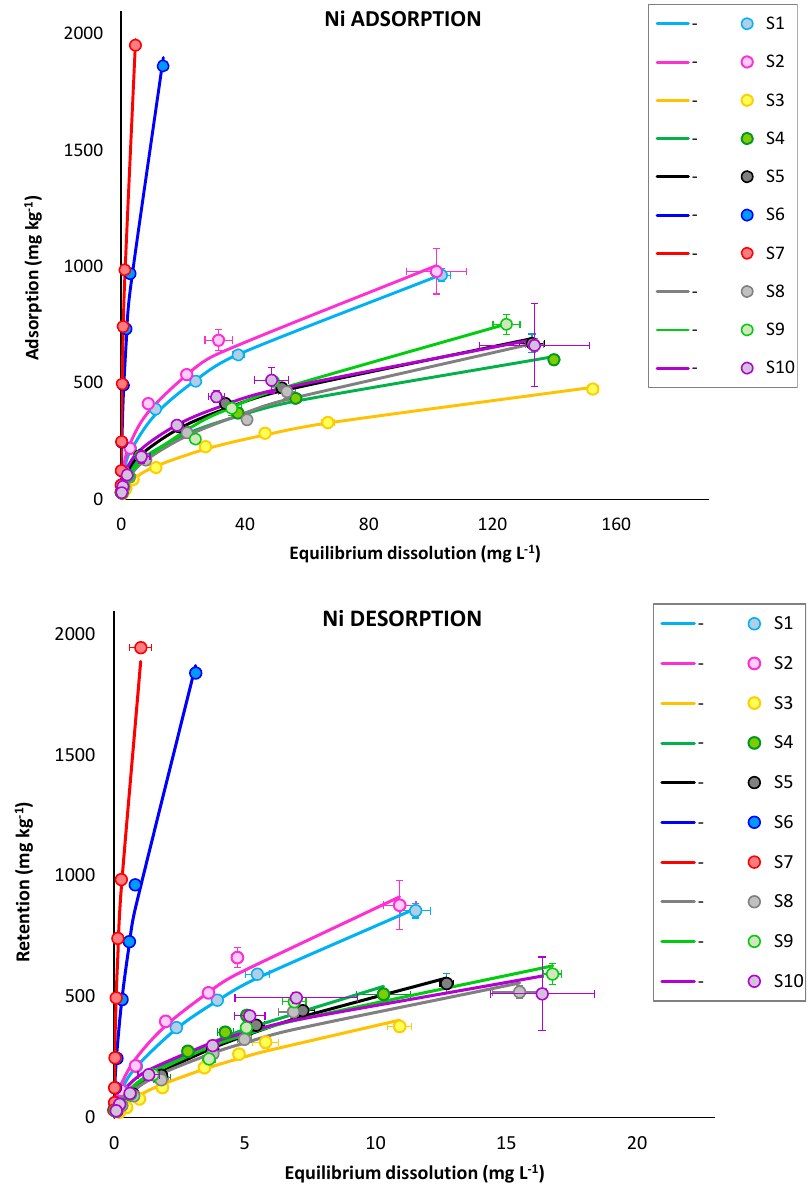
Figure 1. Single adsorption and desorption curves of Ni by soil samples (S1-S10). Table 2. Results derived from Freundlich model: K F (L n mg 1-n kg − 1 ), n (dimensionless) and R 2 values from individual adsorption and desorption data.